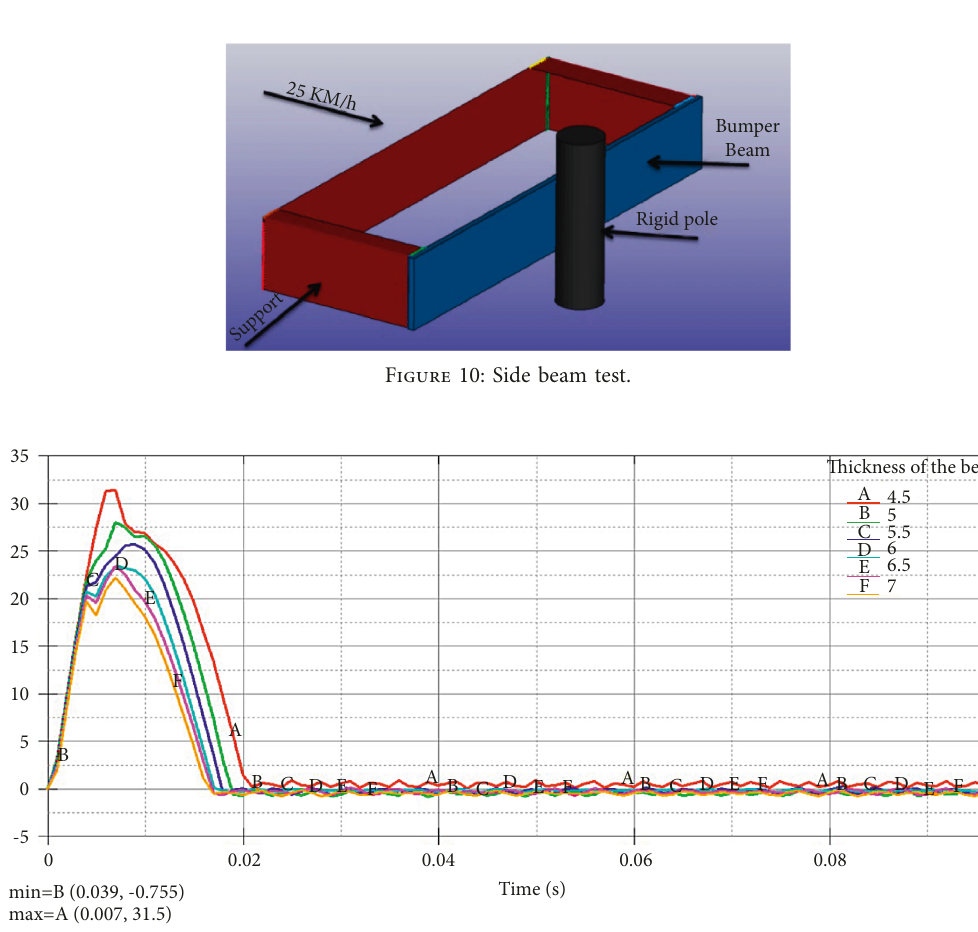
Figure 11: Deformation of different beam thicknesses.